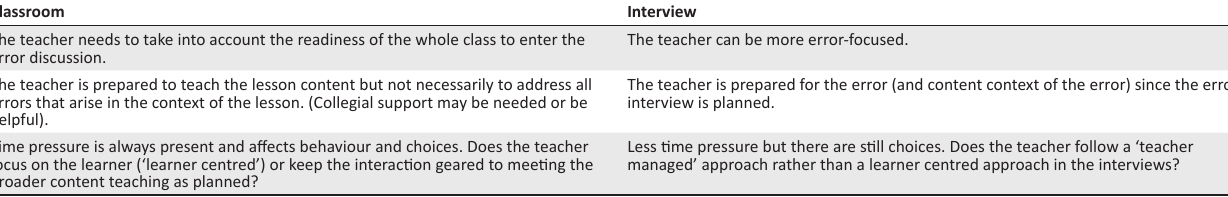
TABLE 2: Contextual differences for engagement with